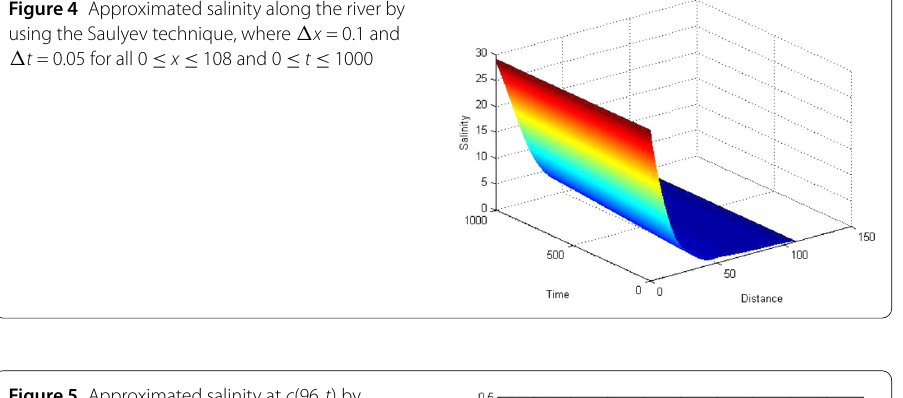
Figure 5 Approximated salinity at c (96, t ) by (cid:4) x = 0.1 and (cid:4) t = 0.05 for all 0 ≤ t ≤ 1000 when u w = 0.3,0.25 and 0.2